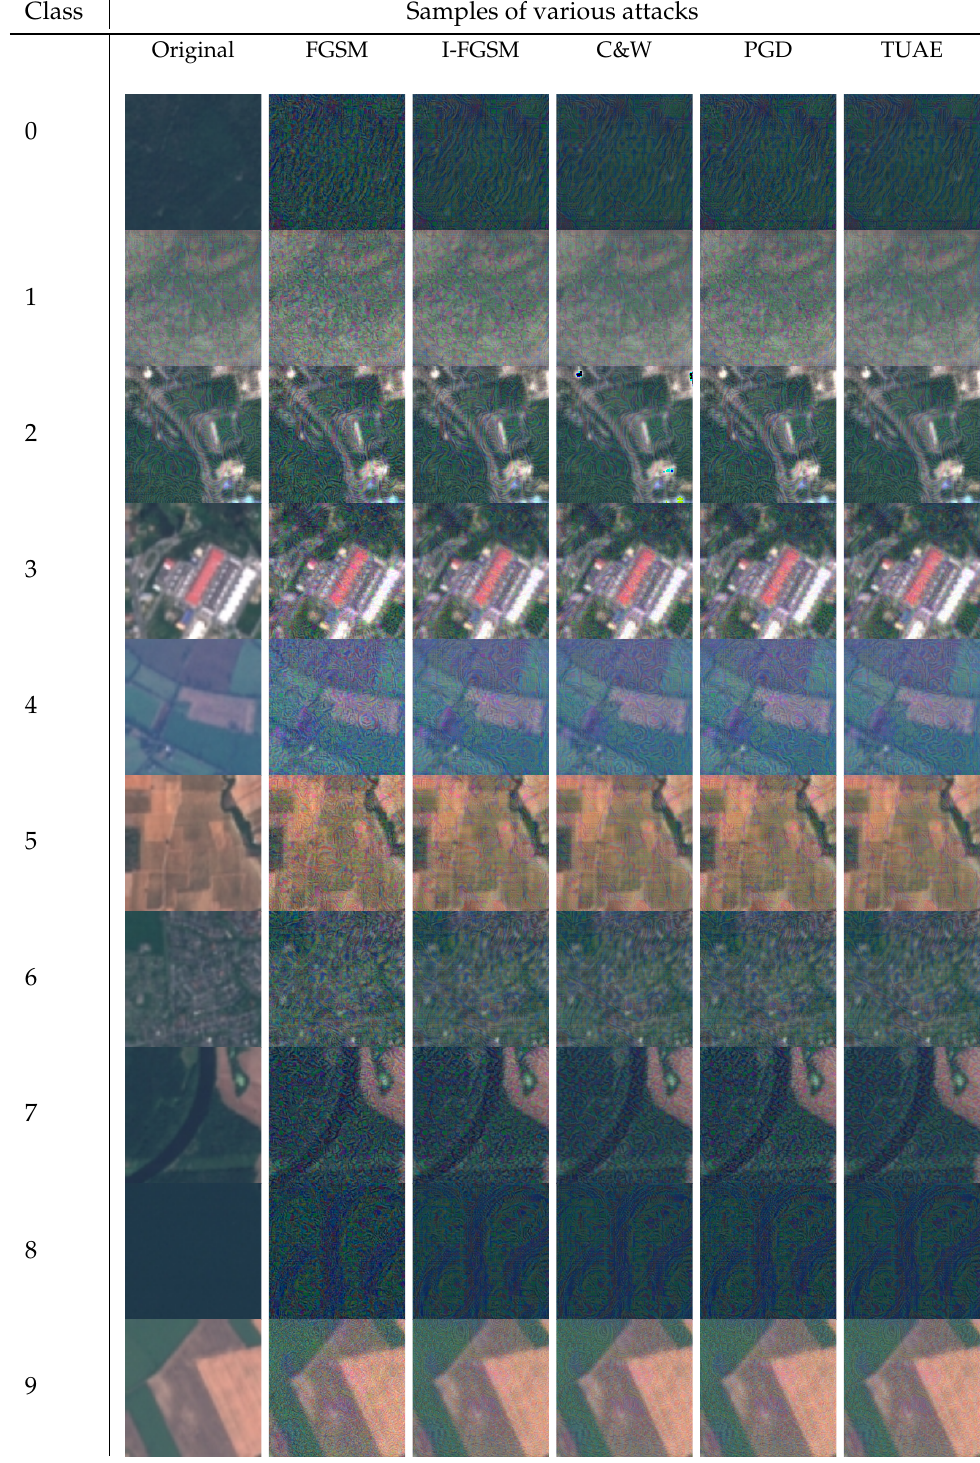
Figure 2. Targeted adversarial samples generated by various attacks. Numbers on the left side are targeted classes when generating adversarial examples. Here, we used AlexNet as the victim model for